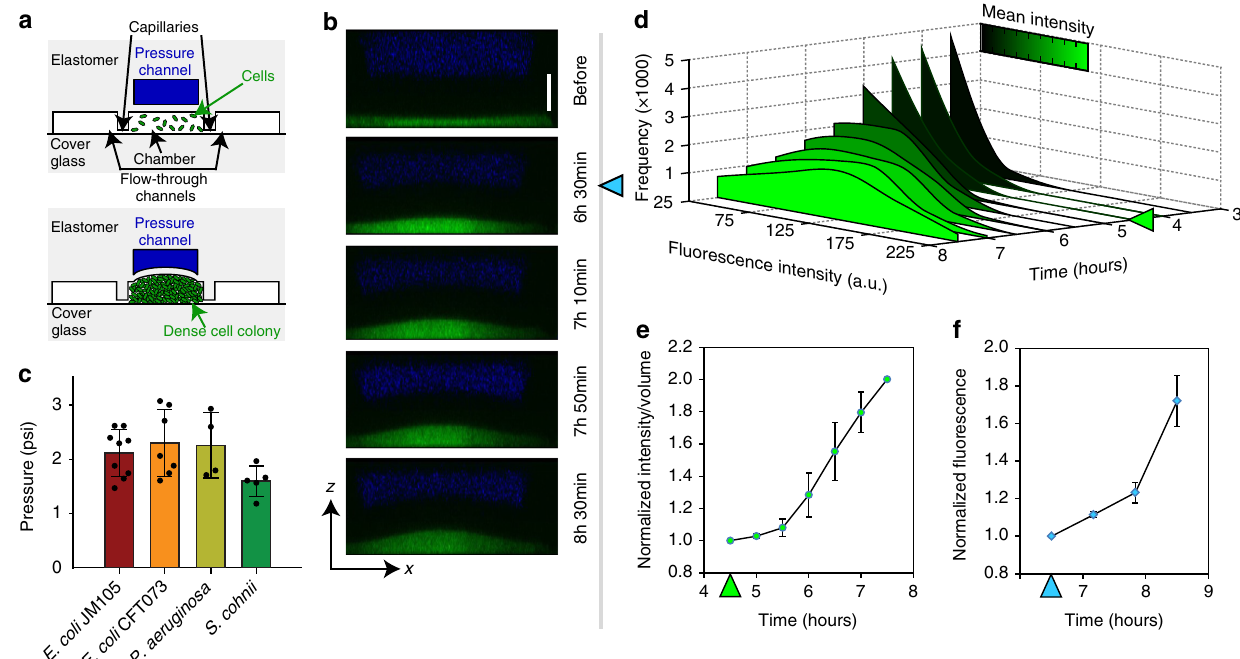
Fig. 1 Pressure buildup as a result of con fi ned growth leads to biochemical stress response. a Schematic cross-section of the micro fl uidic device, illustrating the deformation of the fl exible roof due to bacterial colony growth. b The deformation of the roof [black area between blue (Alexa Fluor 647) and green (GFP-expressing E. coli ) layers] is visualized with CLSM. Scale bar for the vertical dimension, 20 μ m. c Maximum pressures produced by different bacteria; E. coli JM105 ( n = 9); E. coli CFT073 ( n = 7); P. aeruguinosa ( n = 4); S. cohnii ( n = 5). d Distributions of rpoH expression-reporting GFP fl uorescence intensity per pixel in a WFM image of a chamber (in arbitrary units ranged 25 to 225) at various time points, starting 3.5 h after seeding cells into the chamber. The arrow ( t = 4.5 h) indicates when the chamber is completely fi lled with cells. The color of the plot shows the mean intensity at the corresponding time point. e The integral fl uorescence of bacterial colony in the chamber divided by the chamber volume measured at the same time point. The data is normalized to the time point just before the roof deformation becomes detectable ( t = 4.5 h in Fig. 1d) ( n = 3). f GFP expression due to rpoH upregulation measured from xy -sections of confocal imaging. The data was normalized to the time point when roof deformation started to become measurable ( t = 6.5 h in Fig. 1b, indicated by the blue arrow) ( n = 3). Error bars are